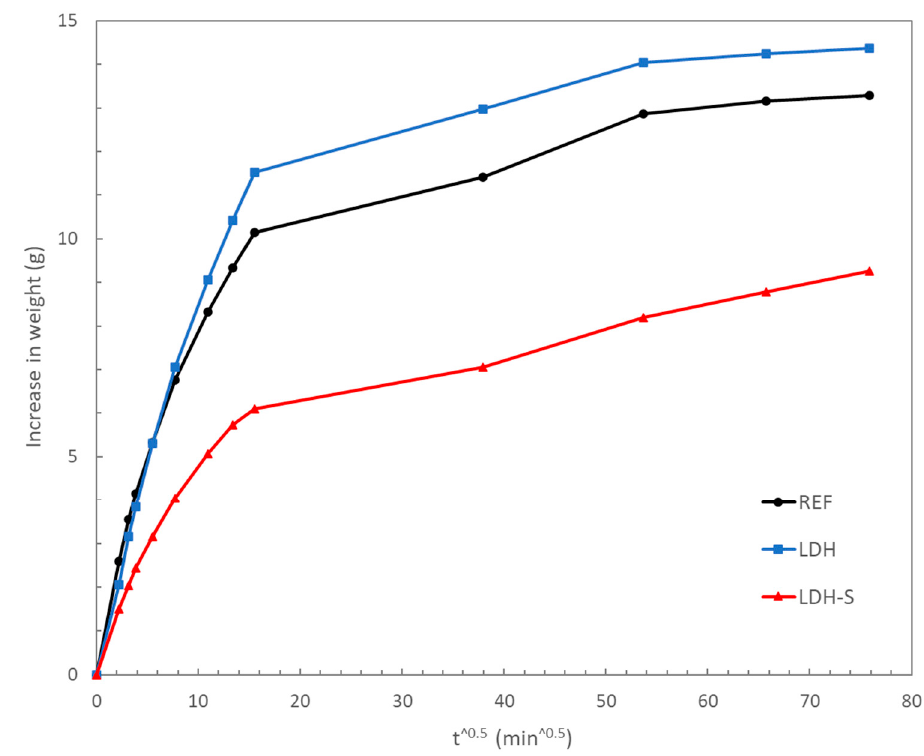
Figure 4. Water capillary absorption tests in mortars after 14 days curing.